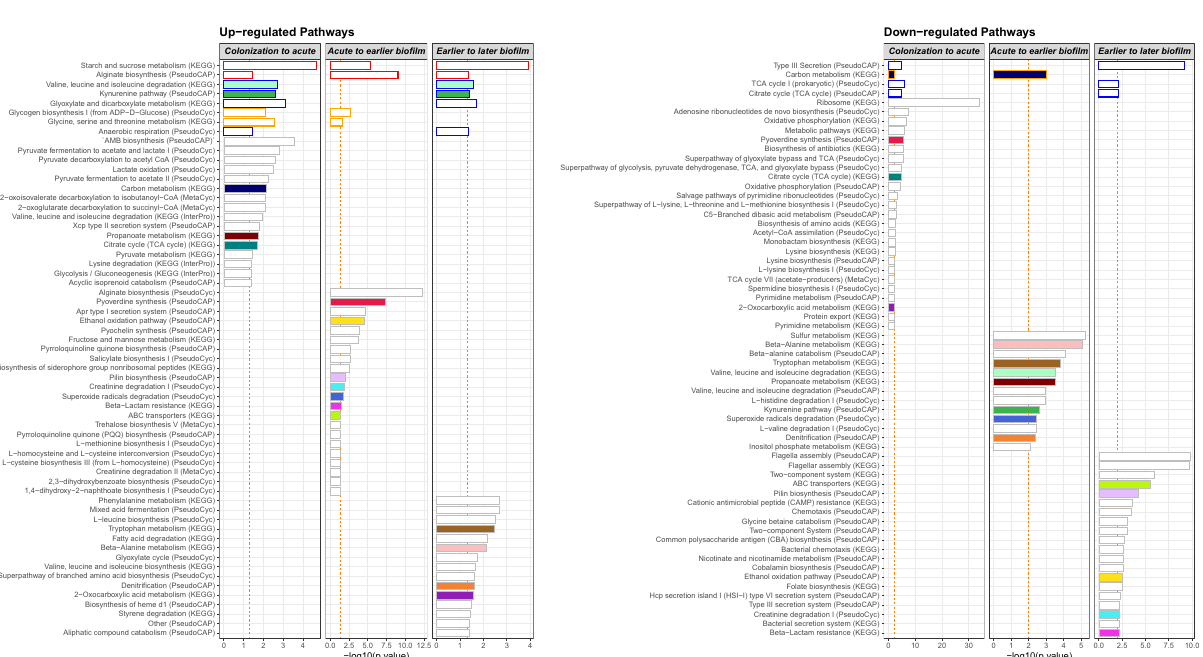
Colonization to acute Acute to earlier biofilm Earlier to later biofilm (KEGG)Alginate biosynthesis (PseudoCAP)Starch and sucrose metabolism (KEGG) (KEGG)Kynurenine pathway (PseudoCAP)Valine, leucine and isoleucine degradation (KEGG)Glycogen biosynthesis I (from ADP−D−Glucose) (PseudoCyc)Glyoxylate and dicarboxylate metabolism (PseudoCAP)`Anaerobic respiration (PseudoCyc)Glycine, serine and threonine metabolism